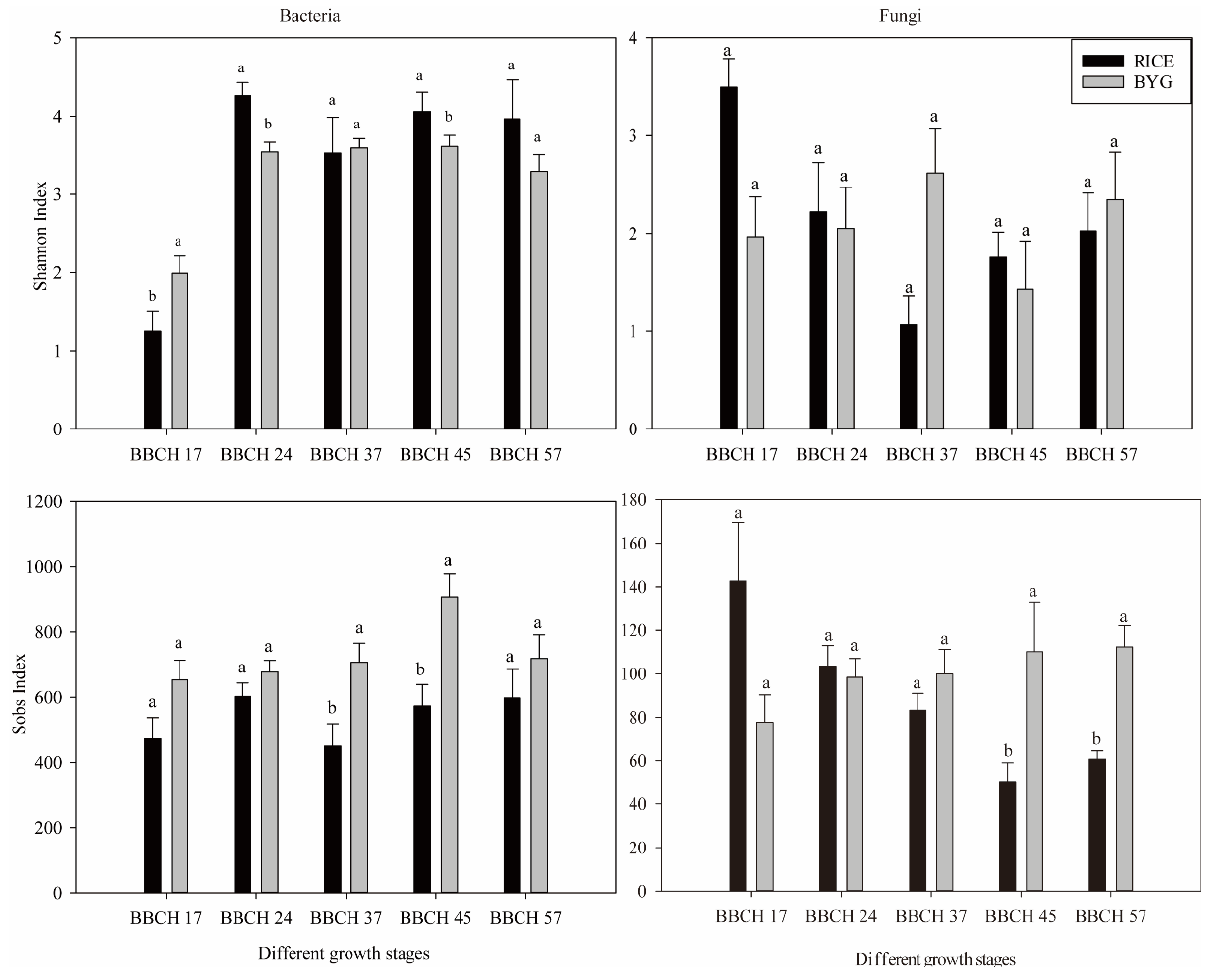
Figure 1. Species diversity (Shannon index) and richness (Sobs index) in rice and barnyardgrass roots at different growth stages for OTUs constructed at 0.03 dissimilarity for bacterial and fungal sequences. Significant differences are indicated by different letters.